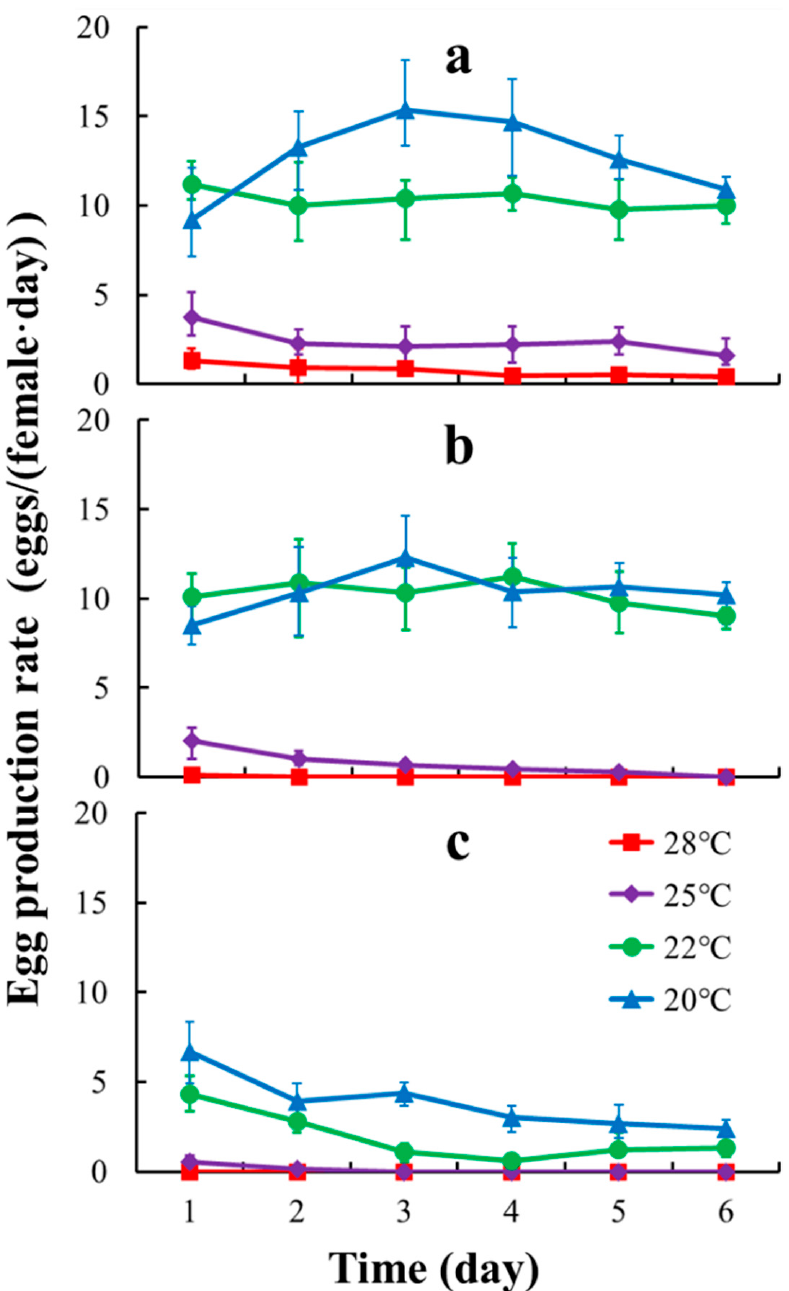
Figure 4. Egg production rates of Acartia bifilosa under different seawater temperatures (20, 22, 25, and 28 °C) and Chl a concentrations ( a ): 15 μ g/L, ( b ): 10 μ g/L, ( c ): 5 μ g/L).